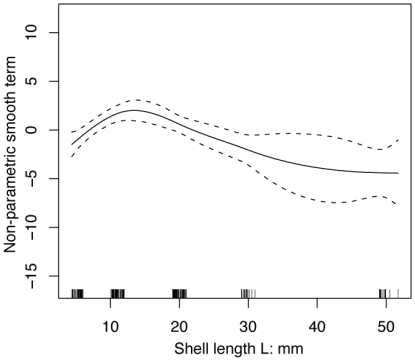
Results of statistical analysis (GAM) for the juvenile to adult Ruditapes philippinarum.A generalized additive model (GAM) with a binomial error distribution to examine how burrowing response co-varied with shell length and sediment hardness in R. philippinarum. The response variable for the model was binary data on vertical burrowing and burrowing mode shift (a and b in Table 1) and burrowing failure (c in Table 1). The solid and dotted lines represent the mean and 95% confidence intervals, respectively.